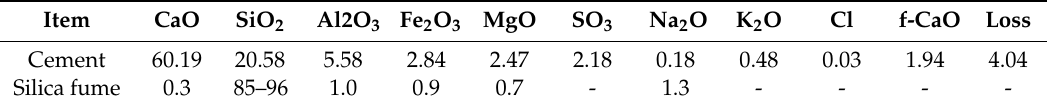
Table 2. The mass percentage of chemical composition of fine aggregate (%).